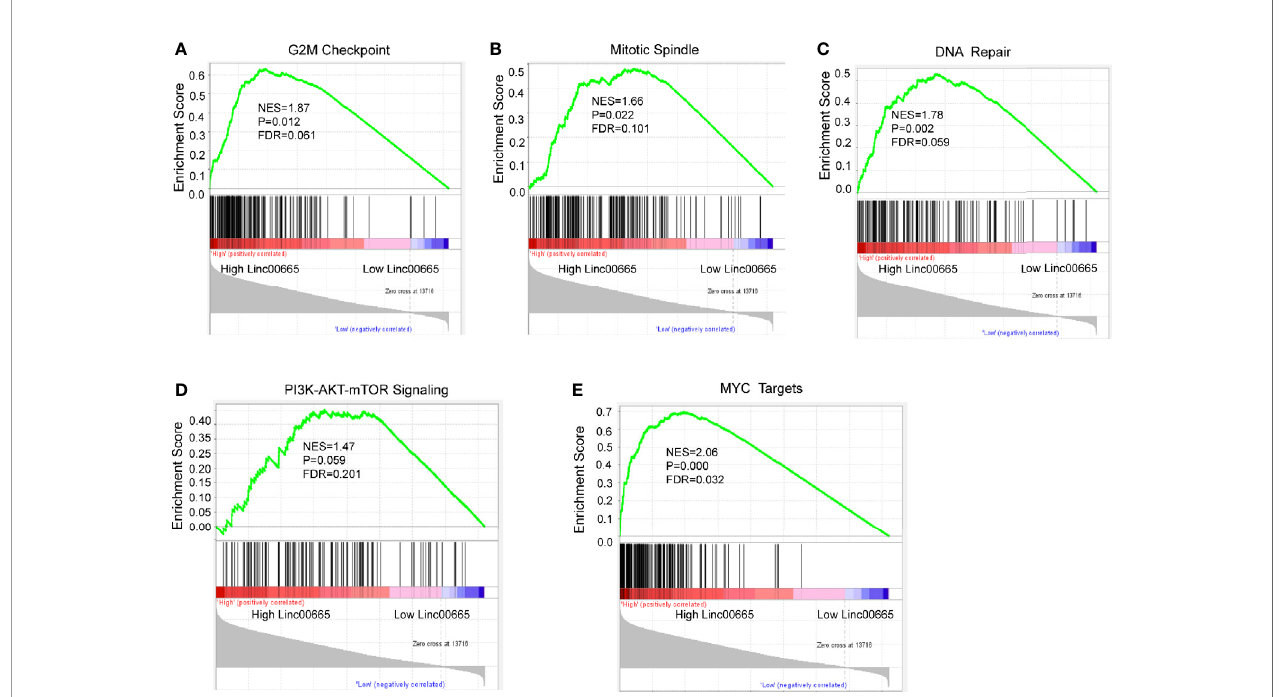
FIGURE 7 | Enrichment plots from GSEA analysis. The Cancer Genome Atlas (TCGA) RNA-seq data were segmented into two groups on the basis of Linc00665 expression. GSEA plot was based on the gene expression pro fi les of Linc00665-high group compared with Linc00665-low group. NES, normalized enrichment score. False discovery rate (FDR) was set at 0.25. GSEA analysis suggested that different signaling pathways were enriched in Linc00665 high expression phenotype. (A) G2M checkpoint; (B) Mitotic Spindle; (C) DNA repair; (D) PI3K/AKT.MTOR signaling pathway; (E) MYC